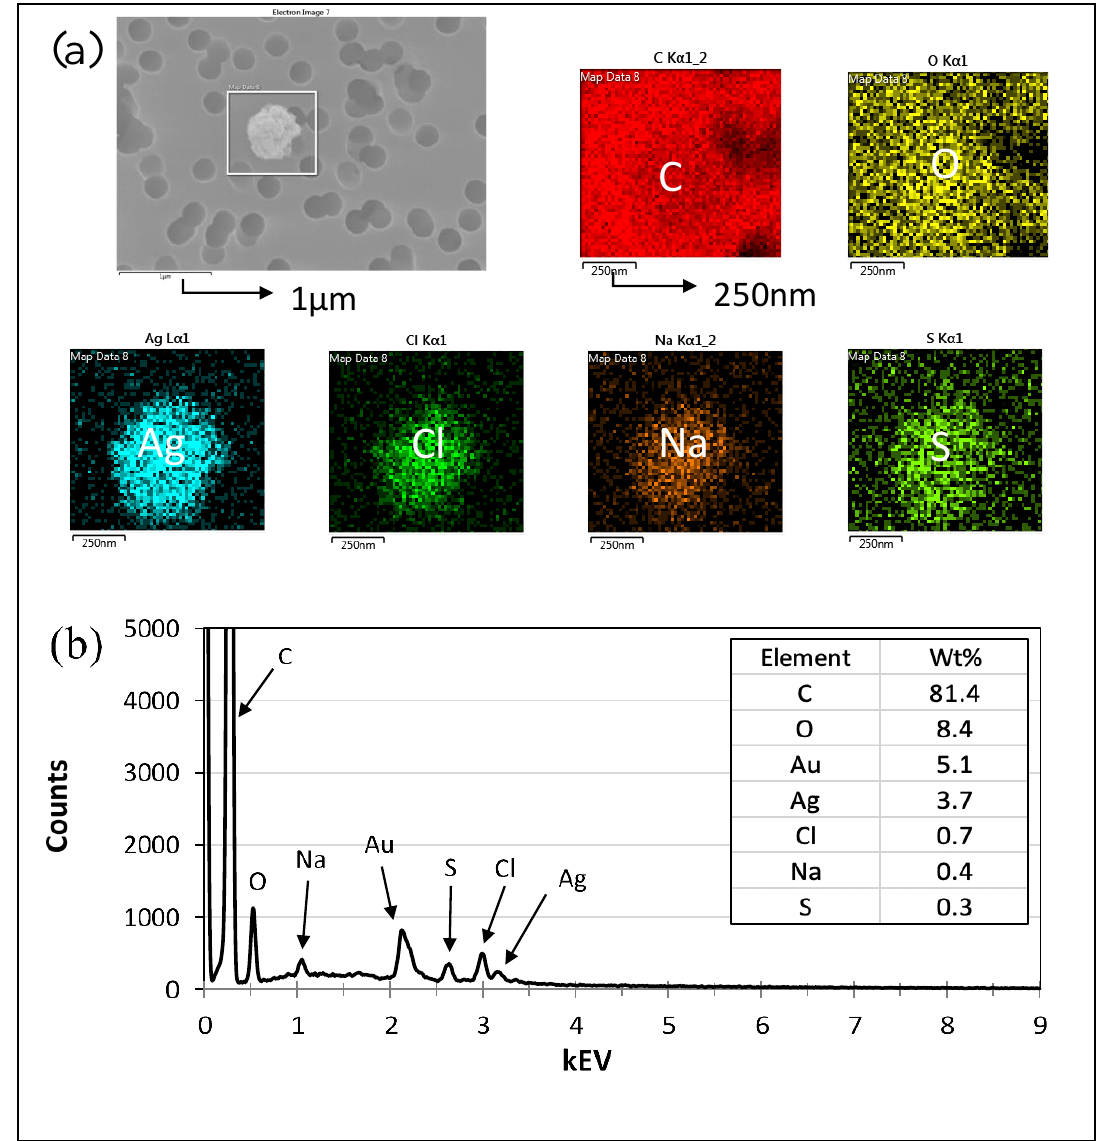
Figure 6. Microscopy analysis of particles from SSS aerosolization using SEM and EDS. ( a ) SEM-EDS image of particles used for analysis. The scale bar of the SEM image is 1 μm. This particle was found to contain the elements carbon (C), gold (Au), oxygen (O), silver (Ag), chlorine (Cl), sodium (Na), and sulfur (S), from left to right, with scale bars of 250 nm. ( b ) EDS analysis of the particle in image (a). Note: Au was used as a coating and therefore was excluded from further analysis or discussion.